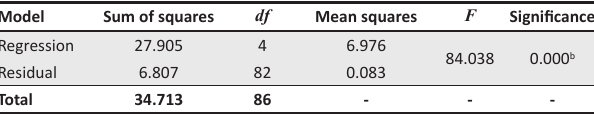
TABLE 6: Regression model summary results. TABLE 7: Analysis of